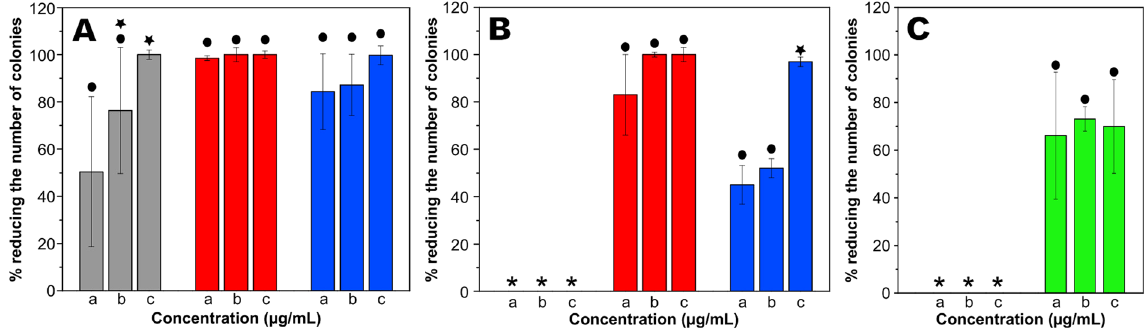
Figure 4. Comparative graph of the bactericidal effect of the synthesized material for ( A ) susceptible and ( B ) ampicillin-resistant E . coli bacteria. Ampicillin is represented by grey bars, Ag@SiO 2 by red bars and Ag@ SiO 2 -Ampicillin nanoparticles by blue bars. Based on TGA analysis, it was possible to determine the ampicillin content in Ag@SiO 2 -Ampicillin nanoparticles, so the concentrations a, b and c of ampicillin are 0.15, 1.55 and 7.76 µ g/mL, respectively. For Ag@SiO 2 and Ag@SiO 2 -Ampicillin, the concentrations a, b and c are 7.43, 74.30 and 372 µ g/mL, respectively. ( C ) Comparative graph of the bactericidal effect of SiO 2 and SiO 2 -Ampicillin nanoparticles for susceptible E . coli bacteria (SiO 2 -Ampicillin nanoparticles is represented by light green bars). The concentrations a, b and c of SiO 2 and SiO 2 -Ampicillin are 7.33, 73.30 and 367 µ g/mL, respectively. Additional information about the samples’ composition are presented in the Supplementary Information. The results shown are the average of each condition. The symbol * represents the concentrations that caused no inhibition of bacterial growth. Statistical analysis was performed according to the t-test . The symbols on top of the bars (circles and stars) indicate mean P < 0.05 for the same group. Symbols in common denote that the data are not statistically different. In addition, no statistical differences were observed when concentrations a, b or c of